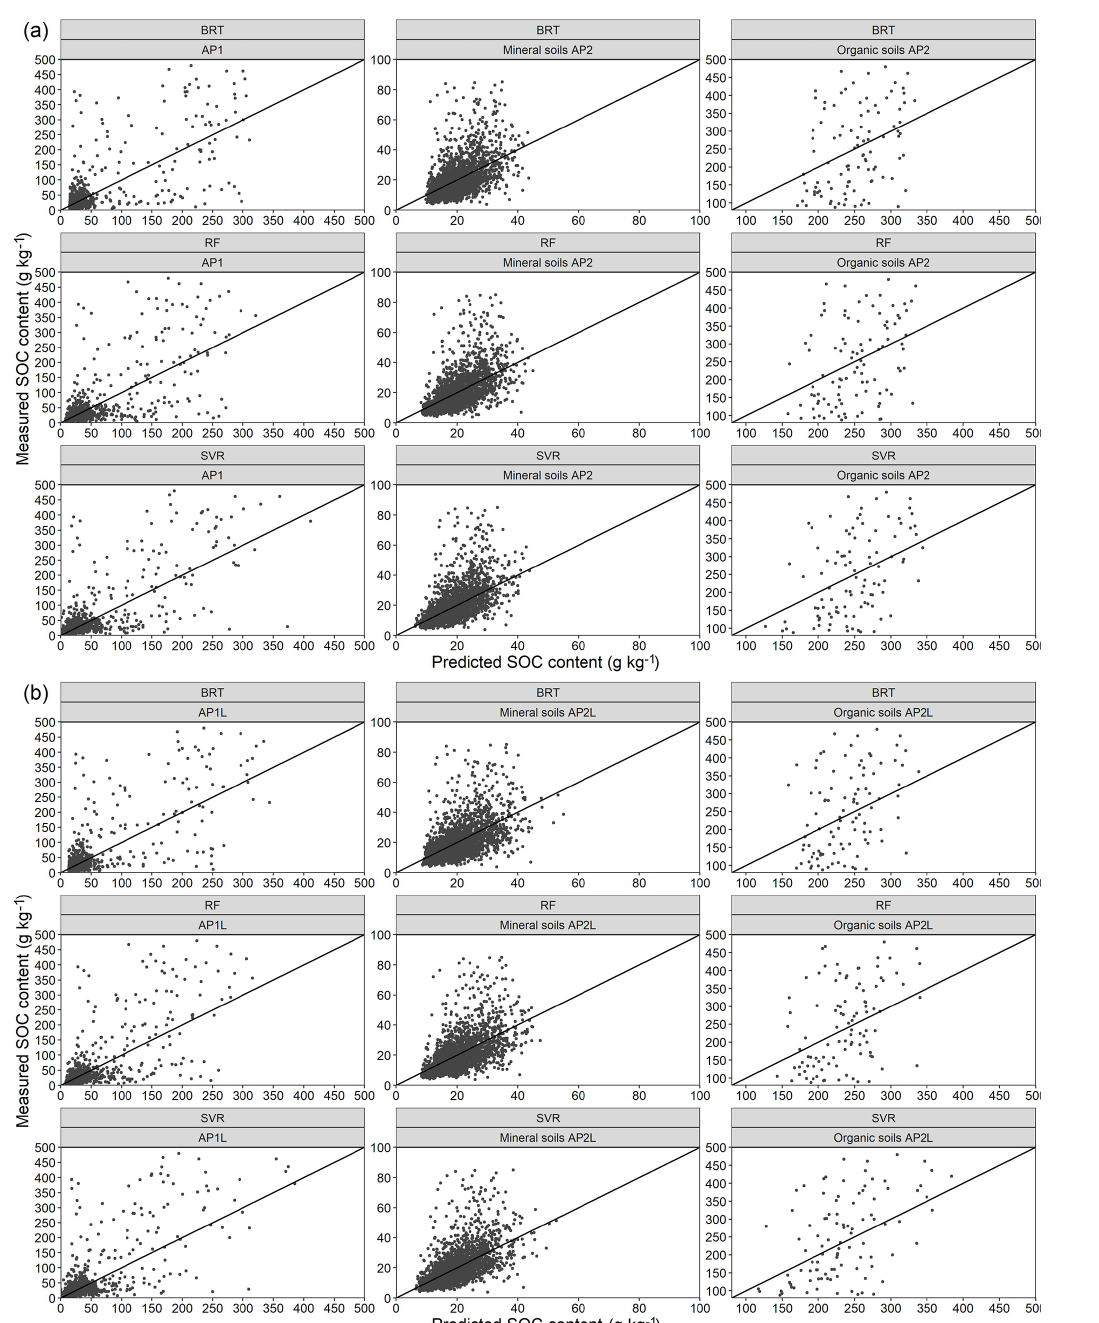
Figure 5. Scatterplot of residuals for (a) the AP1 approach and mineral and organic soils of AP2 and for (b) the AP1L approach and mineral and organic soils of AP2L. The abbreviations used in the figure are as follows: BRT – boosted regression trees, RF – random forest, and SVR – support vector